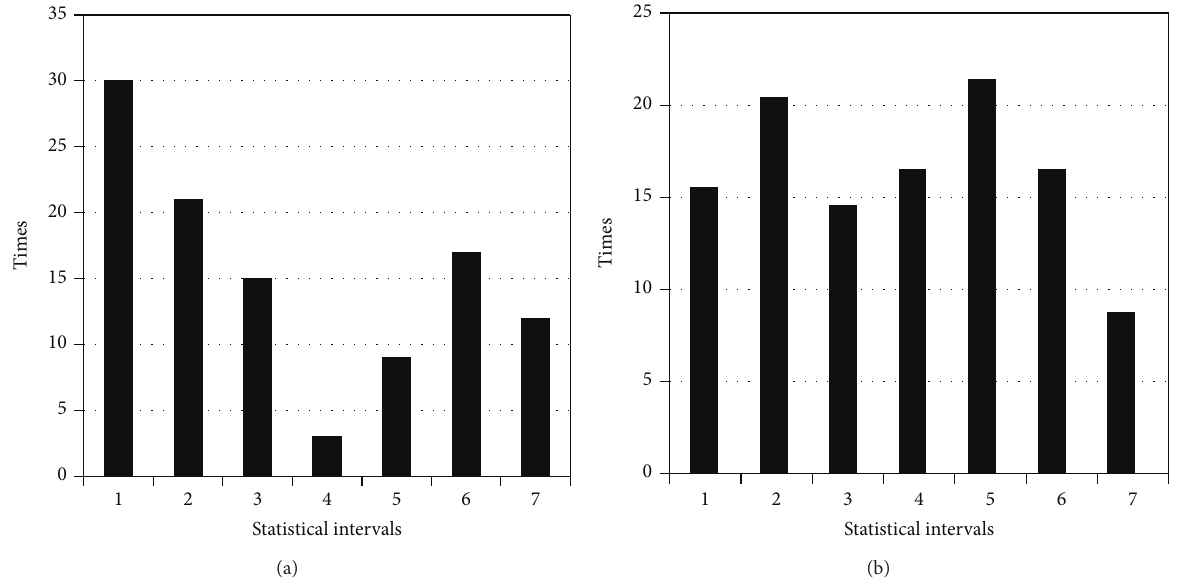
Figure 8: (a) Protocol type feature: port number feature. (b) Statistical waveform.